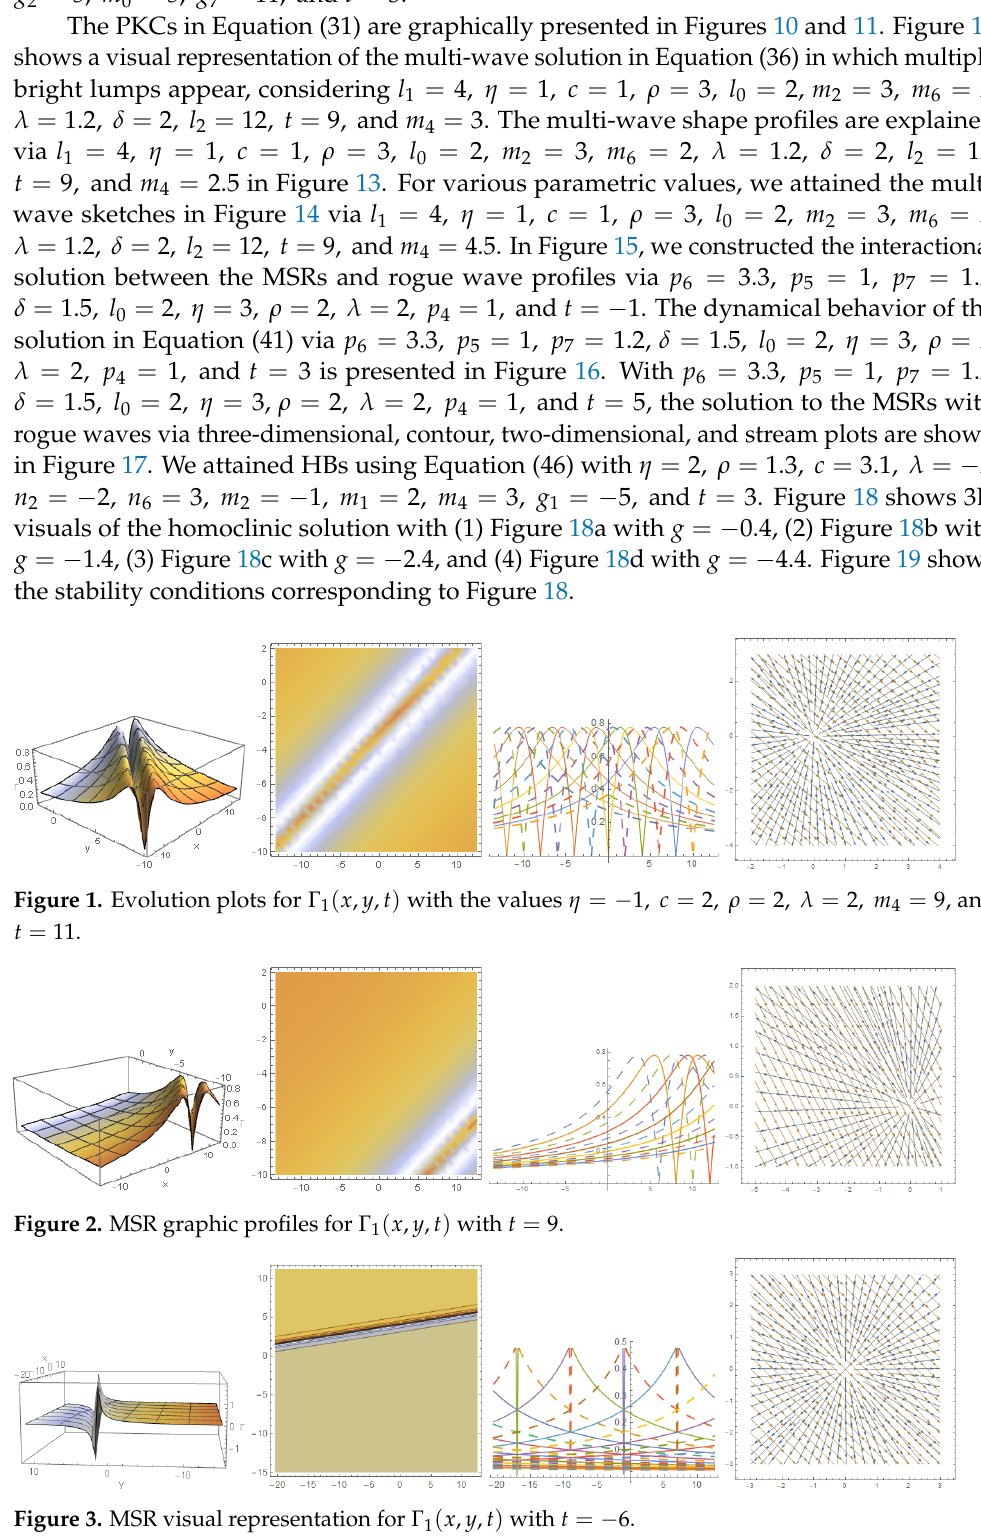
Figure 3. MSR visual representation for Γ 1 ( x , y , t ) with t = −